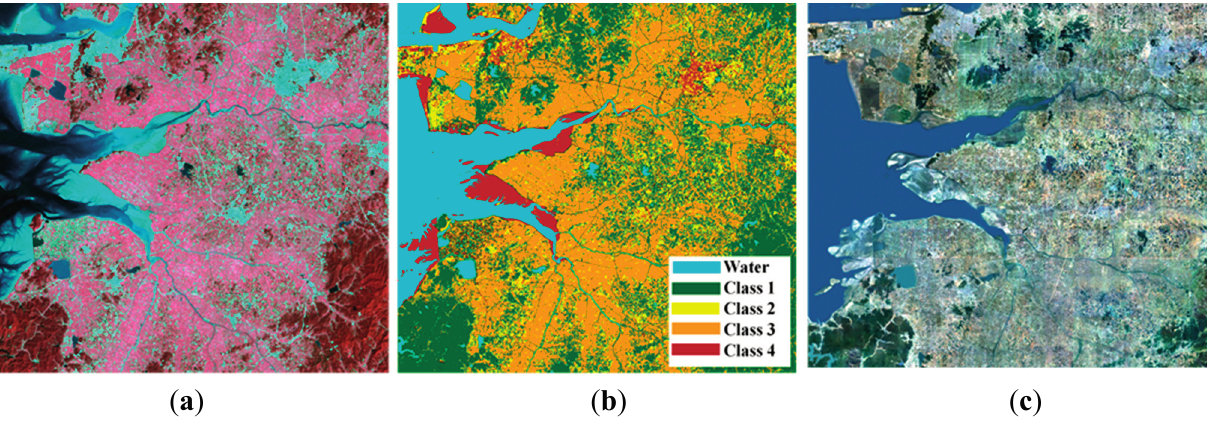
Figure 4. ( a ) Landsat TM imagery; ( b ) land cover map created using Landsat imagery (In general, class 1 represented forested land, class 2 was urban land and class 3 contained agricultural land, rangeland and wetland, and barren land and tideland consisted of class 4); ( c ) orthorectified aerial image over the study area. Figure 4 is Landsat TM imagery, the land cover map created using ISODATA algorithm and